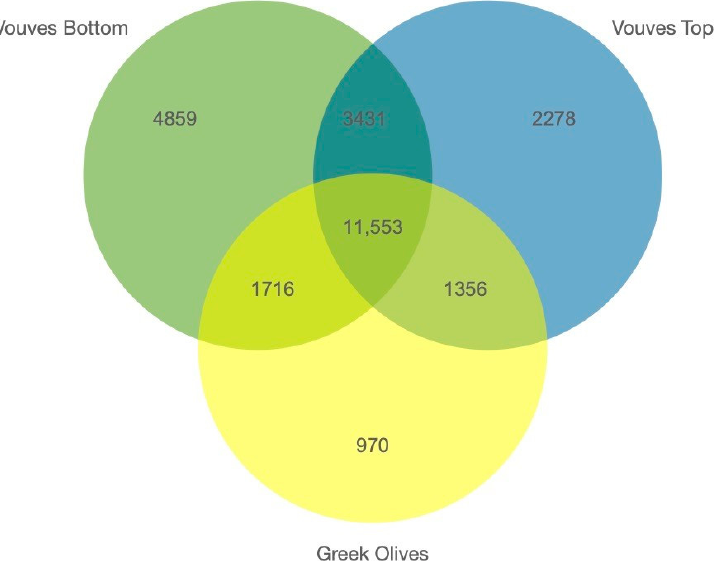
Figure 5. Venn diagram showing the number of High Impact (HI) variants shared between the Vouves tree bottom (green), the Vouves tree top sample (blue) and the other Greek accessions (yellow). The third group had 970 genes associated with high impact changes shared by all the Greek accessions (‘Kalamon’, ‘Koroneiki’, ‘Mastoidis’, ‘Mavreya’, ‘Megaritiki’ and ‘Myrto- lia’) but absent in the Vouves tree. This cluster presented an enrichment in the following “Golgi to plasma membrane transport” (GO: 0006893), “ATP metabolic process” (GO: 0046034), “Chromosome segregation” (GO: 0007059), “Sucrose biosynthetic process” (GO: 0005986), “DNA integration” (GO: 0015074), “Regulation of cytokinesis” (GO: 0032465), “Peptidyl-lysine modification to peptidyl-hypusine” (GO: 0008612) and “Telomere mainte- nance” (GO: 0000723) (Figure 6C). The list of the genes as well as the variants and